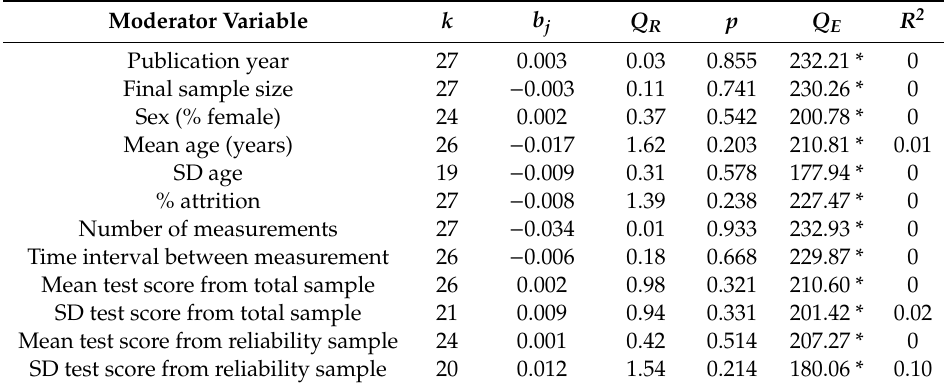
Table 3. Results of the mixed-effects meta-regressions for the continuous moderator variables on the intraclass correlation coefficient (ICC) estimates obtained from intra-tester and inter-session reliability of the Biering-Sorensen test.